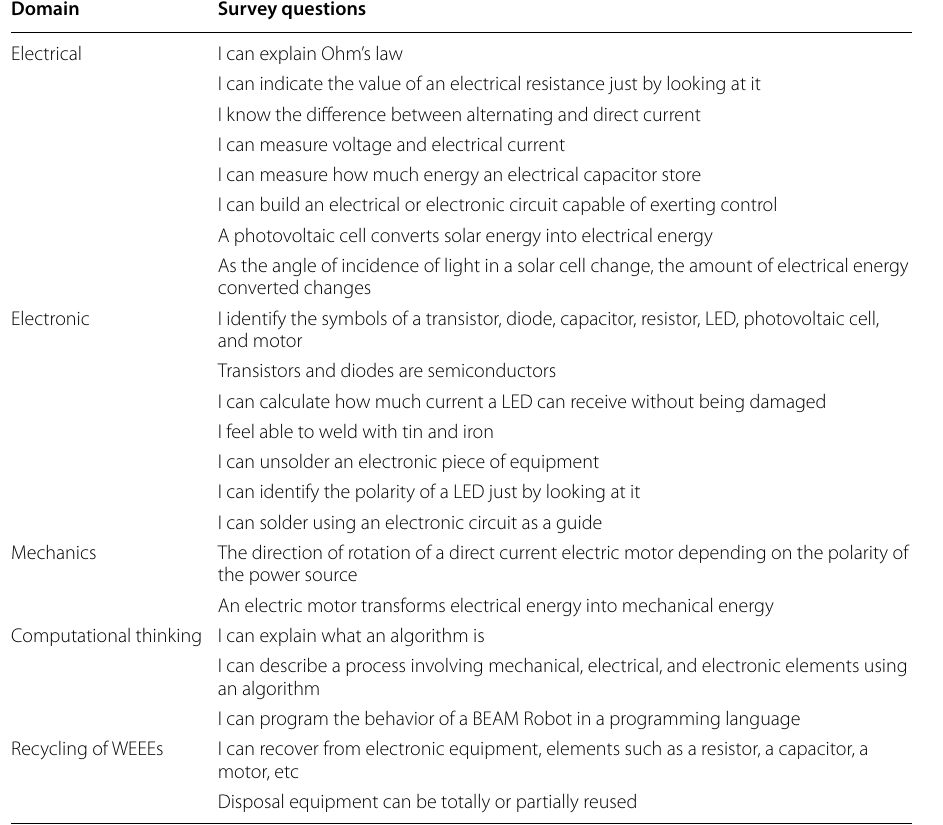
Table 2 STEM Knowledge and Skills Pre/Post Survey Domain